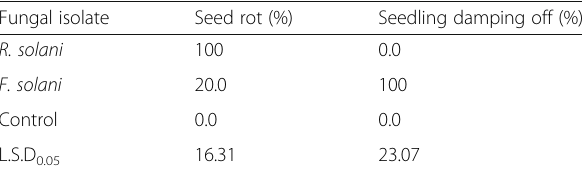
Table 3 Effects of R. solani and F. solani on seed rot, and seedlings damping-off disease of cucumber on PDA Fungal isolate